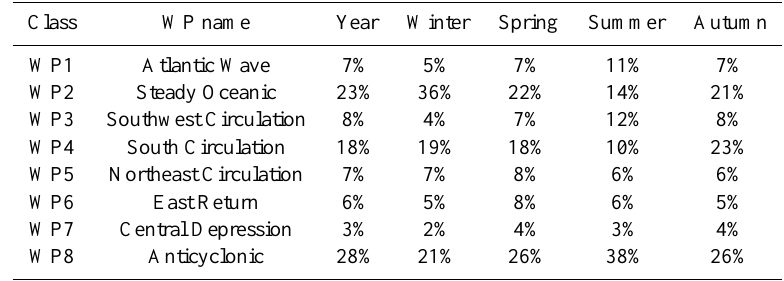
Fig. 3. Average geopotential height at 1000hPa of the eight WP (A) and the ratio of the mean WP to global mean precipitation (B). The frame highlights the area of interest (from 6.2 ◦ W to 12.9 ◦ E, and from 38.0 ◦ N to 50.3 ◦ N) and the arrows indicate the atmospheric flow of low layers. Table 1. Yearly and seasonal statistics of occurrence for the eight WP (records for the period